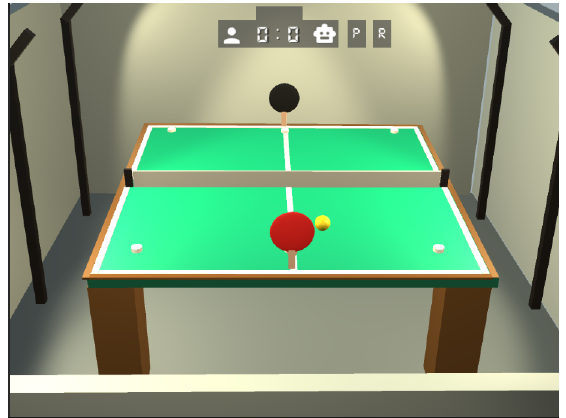
Figure 4. Game screen. Source: Author